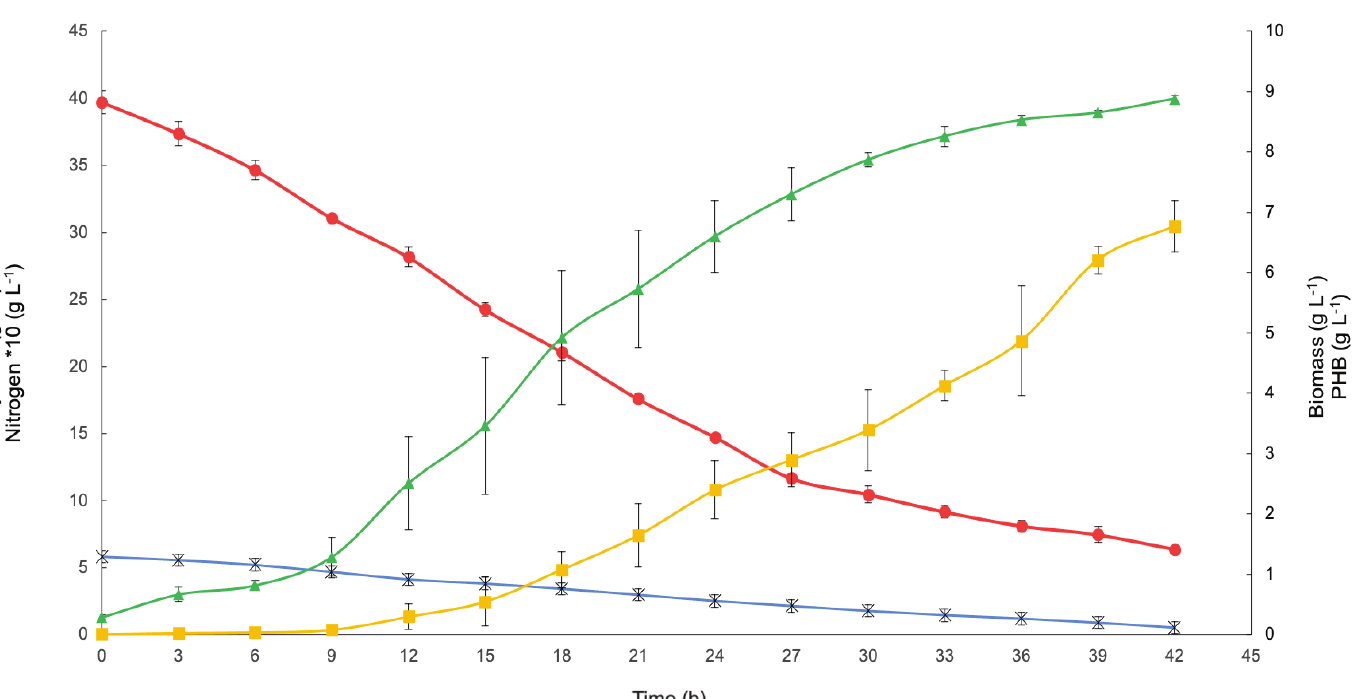
Fig. 3 – Batch kinetic data of total biomass, nutrient consumption, and PHB production for C. necator in a 7-L bioreactor (glycerol concentration – circle, biomass concentration – triangle, PHB concentration – square, nitrogen concentration – batch cultivation of C. necator for PHB production.